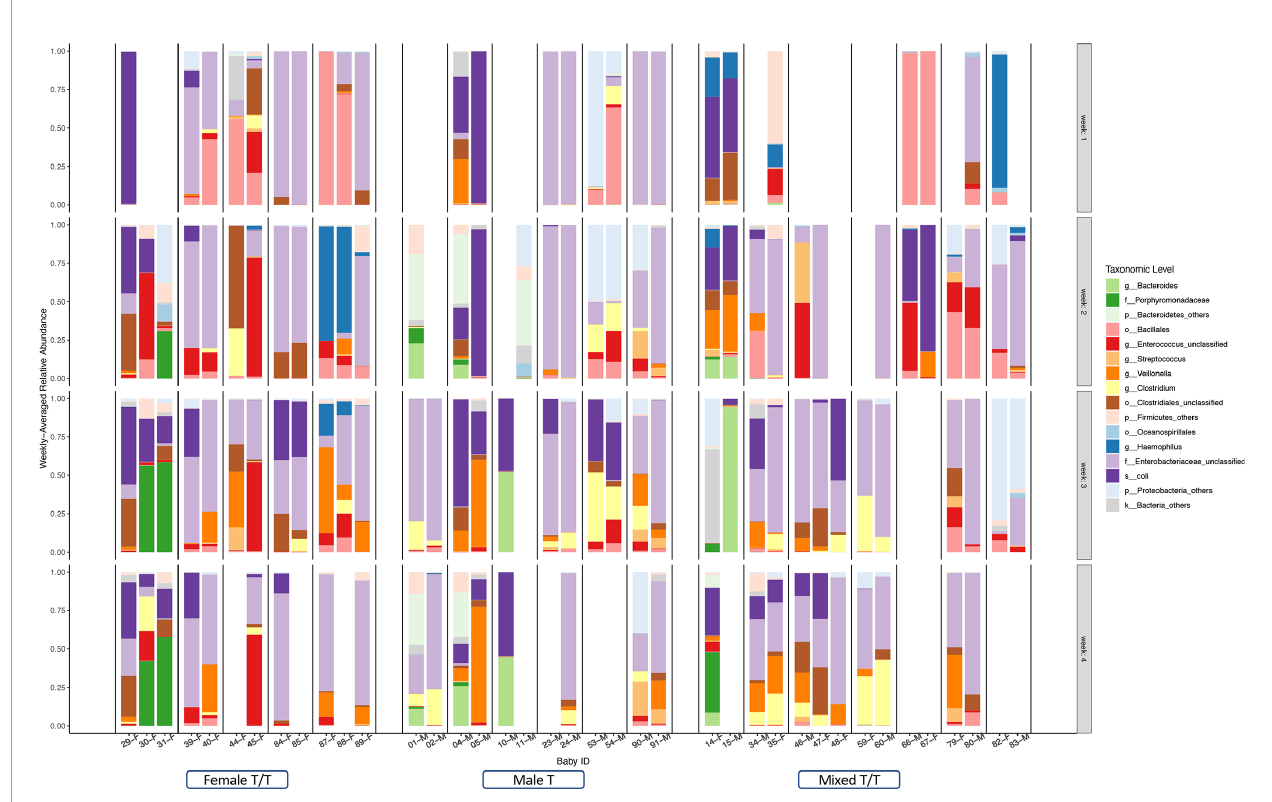
FIGURE 5 | Summarized weekly relative abundance of taxonomic levels for each infant among Twins/Triplets. The relative abundance of the included twins/triplets was presented on a weekly basis in the fi rst four weeks of NICU stay. Each column presents one infant, the sex and study-ID of each infant was listed on the bottom. The twins/triplets from the same mother were juxtaposed and babies from different mothers were separated by a black dotted line. Blank columns indicate no stool sample was obtained in that week. Different colors of the bar represent selected taxonomic